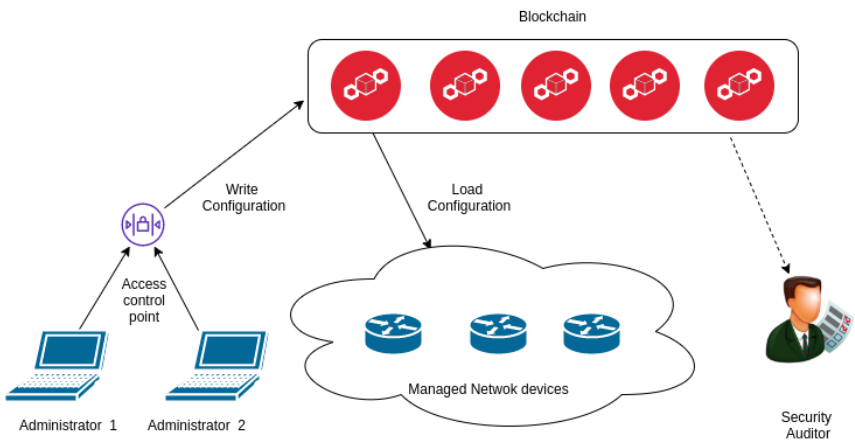
Figure 1. Blockchain architecture for management network devices. Reproduced from [8] and permission obtained from IEEEE.